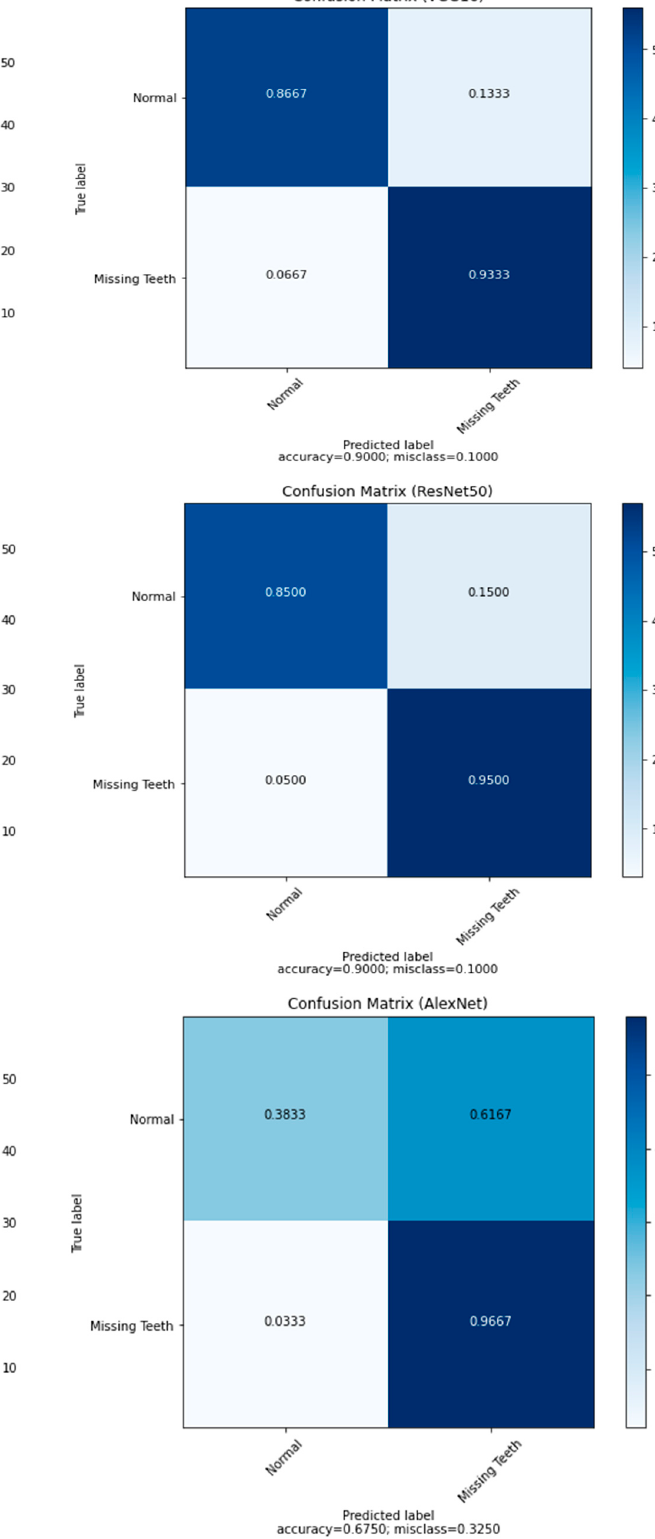
Figure 11. Confusion matrix for all pretrained models.